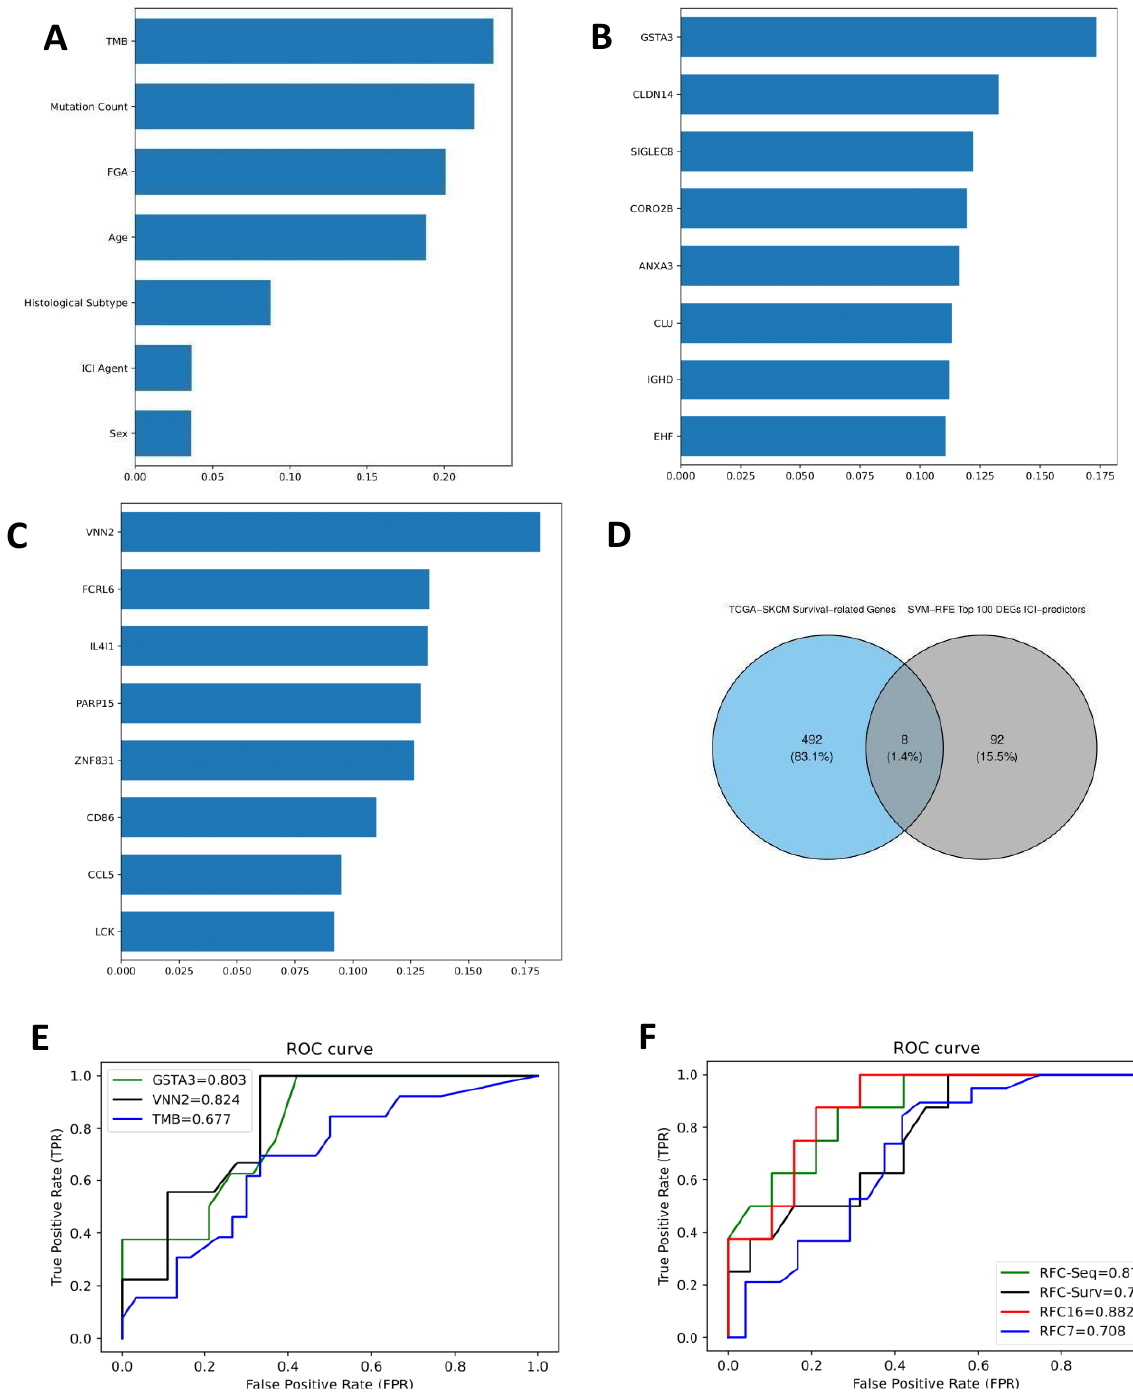
Figure 2. ICI prediction models : ( A ) Feature contribution of RFC7 model showing TMB as the strongest predictor of response. ( B ) Feature contribution of RFC-Seq model showing GSTA3 as the strongest predictor of response. ( C ) Feature contribution of RFC-Surv model showing VNN2 as the strongest predictor of response. ( D ) Venn diagram showing the intersection between TCGA−SKCM Survival−related Genes and SVM−RFE Top 100 DEGs ICI−predictors. ( E ) The ROC curve of the top associated features from RFC7, RFC-Seq and RFC-Surv models. ( F ) The ROC curve of RFC7, RFC-Seq and RFC-Surv models.